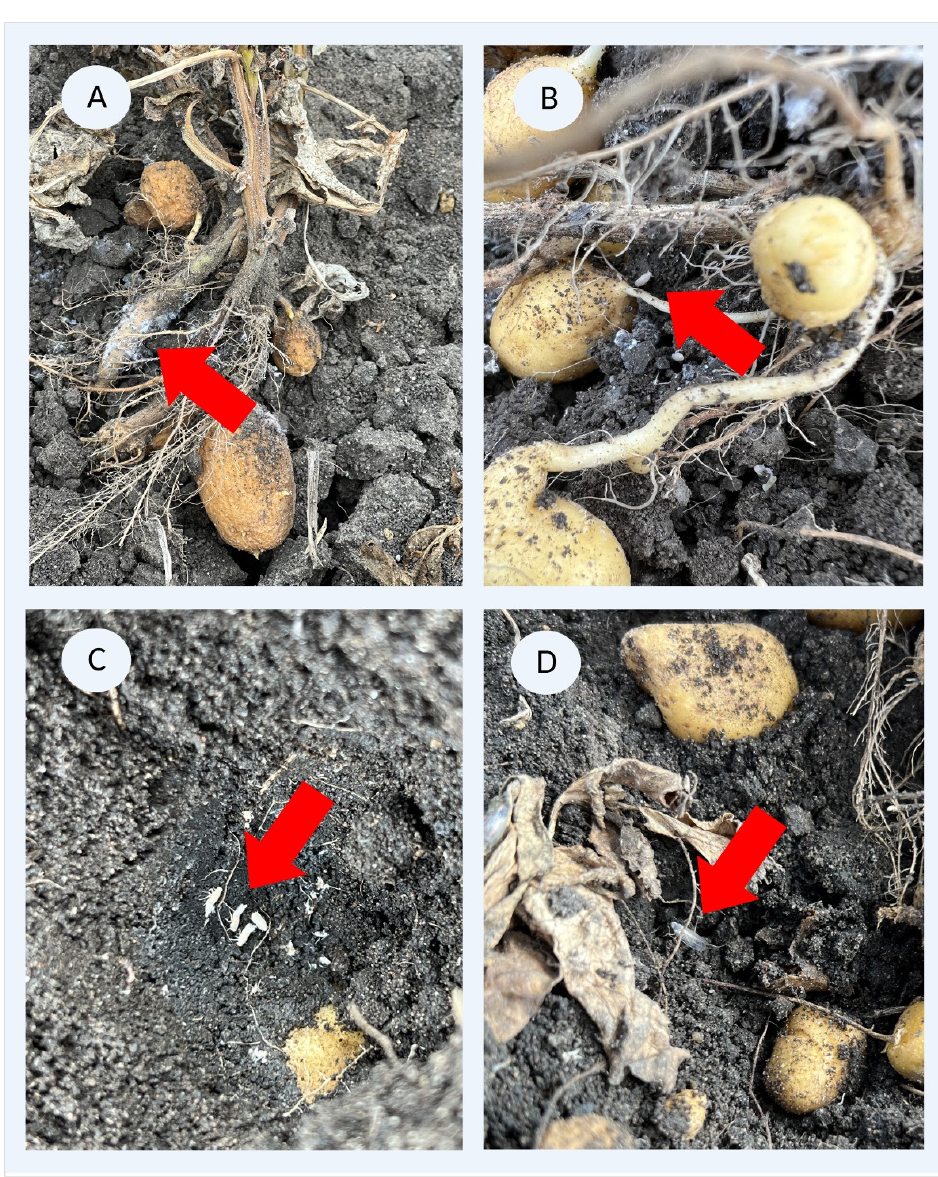
Figure 1. Pentastiridius leporinus found on potato plants in Ibersheim, September 2022. ( A ) Subterranean colonization of roots and tubers by nymphs, characterized by white, waxy filamentous residues. ( B ) Nymphs on the potato tubers and roots. ( C ) Colony of nymphs at different developmental stages and residues of molting, hidden under potato tubers. ( D ) Adult P. leporinus found in the soil. Red arrows indicate nymphs ( A – C ) and adults ( D